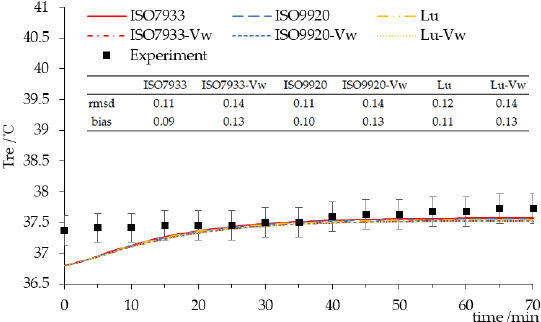
Figure 5. Time-course changes in the rectal temperature for the LC. Lu—the rectal temperature predicted by the PHS model with the clothing correction algorithm of Lu. Lu- v w —the rectal temperature predicted by the PHS model with the clothing correction algorithm of Lu on adding the walking speed input parameter.